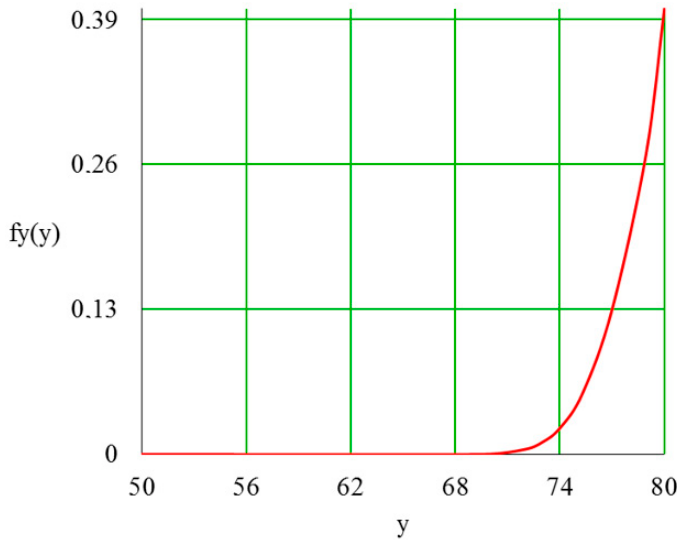
Figure 5. The probability density plot— G 4.